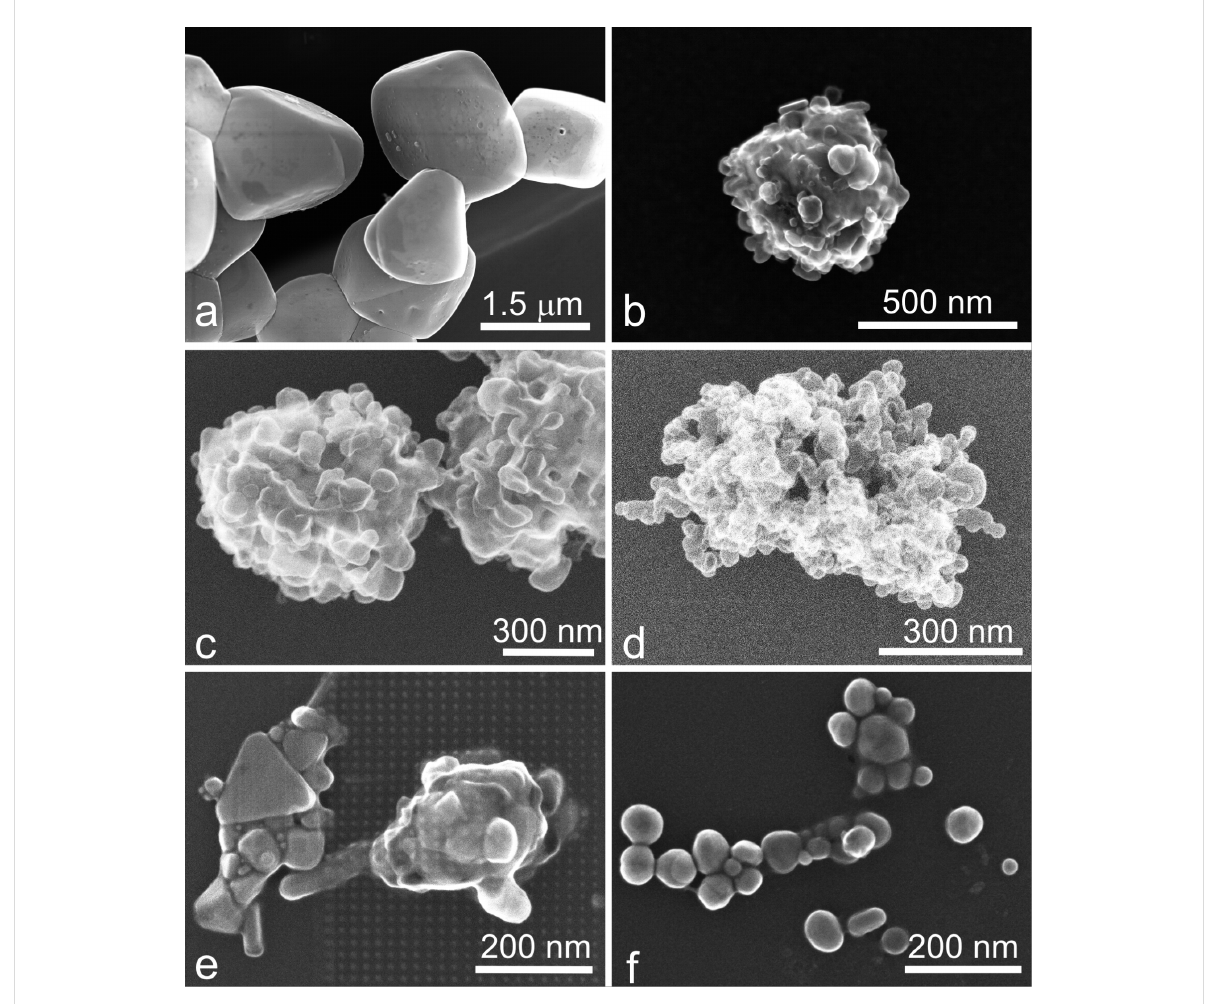
Figure 3: SEM micrographs showing different stages during the photoconversion of AgCl microparticles (a) to AgNPs (f).